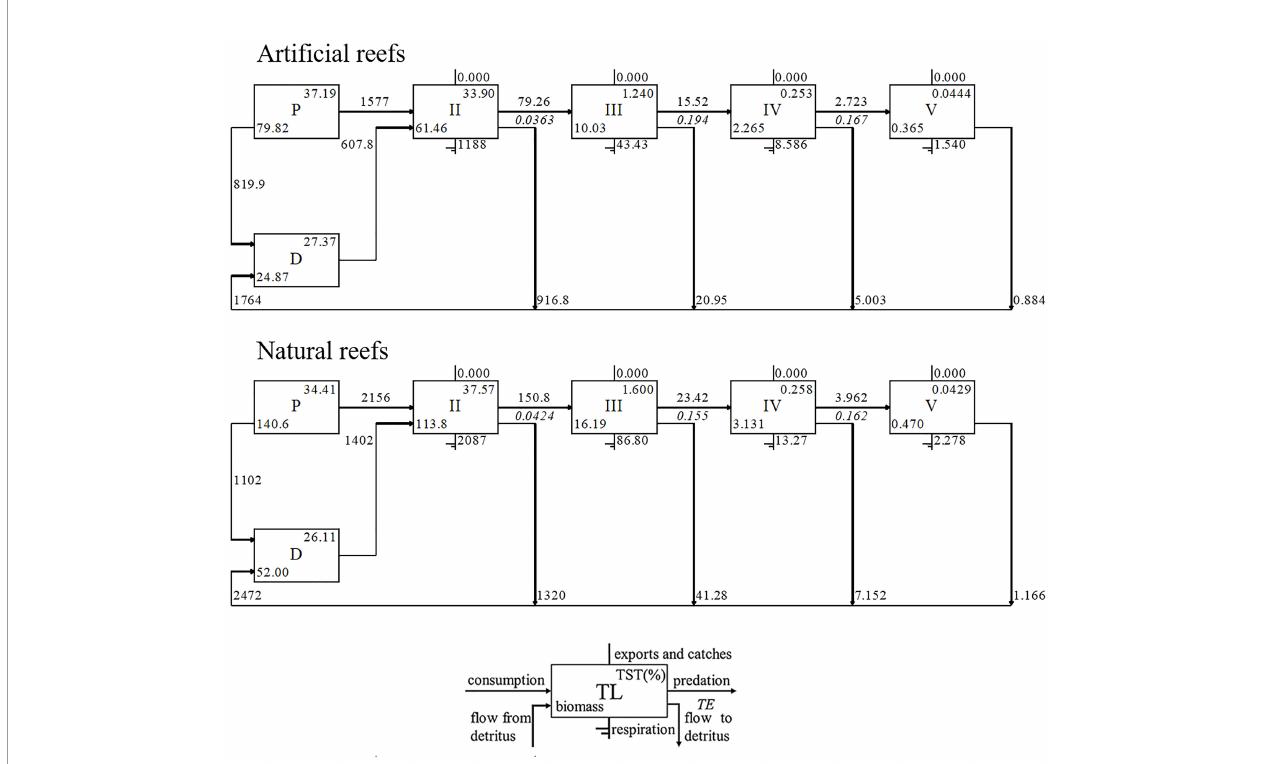
FIGURE 4 | Lindeman spine diagram at the arti fi cial and natural reef ecosystems on the coast of Yellow Sea,